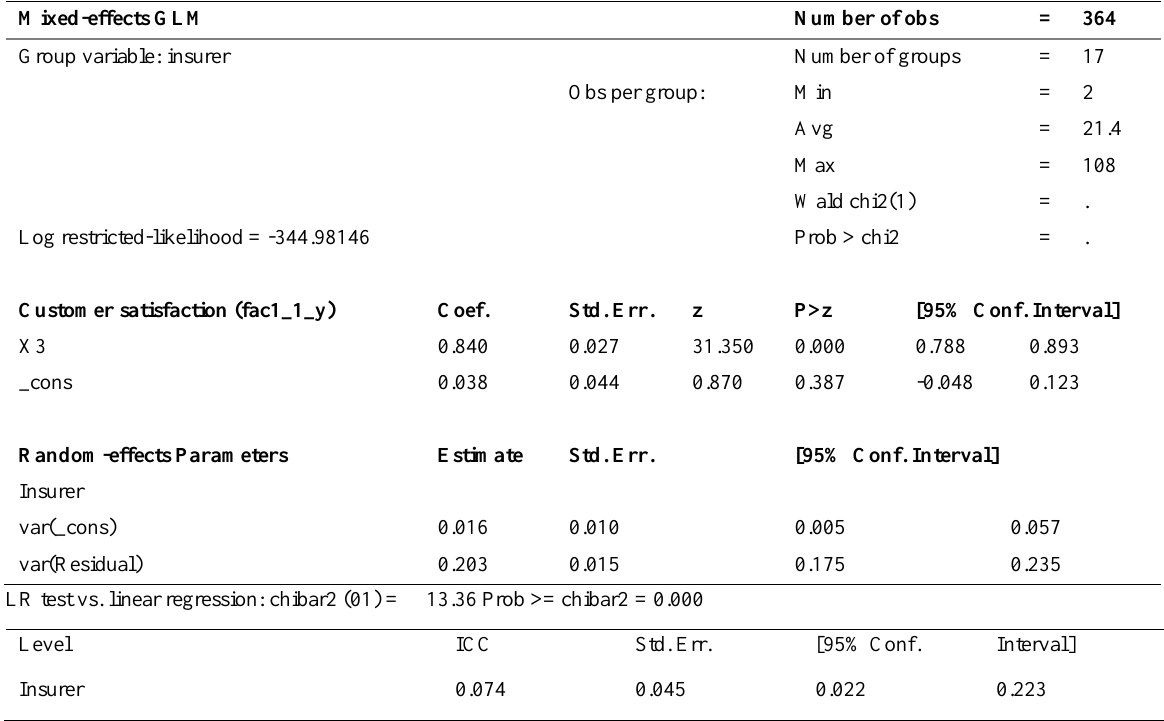
Table 3: Effect of Reliability: fixed effect with random intercept